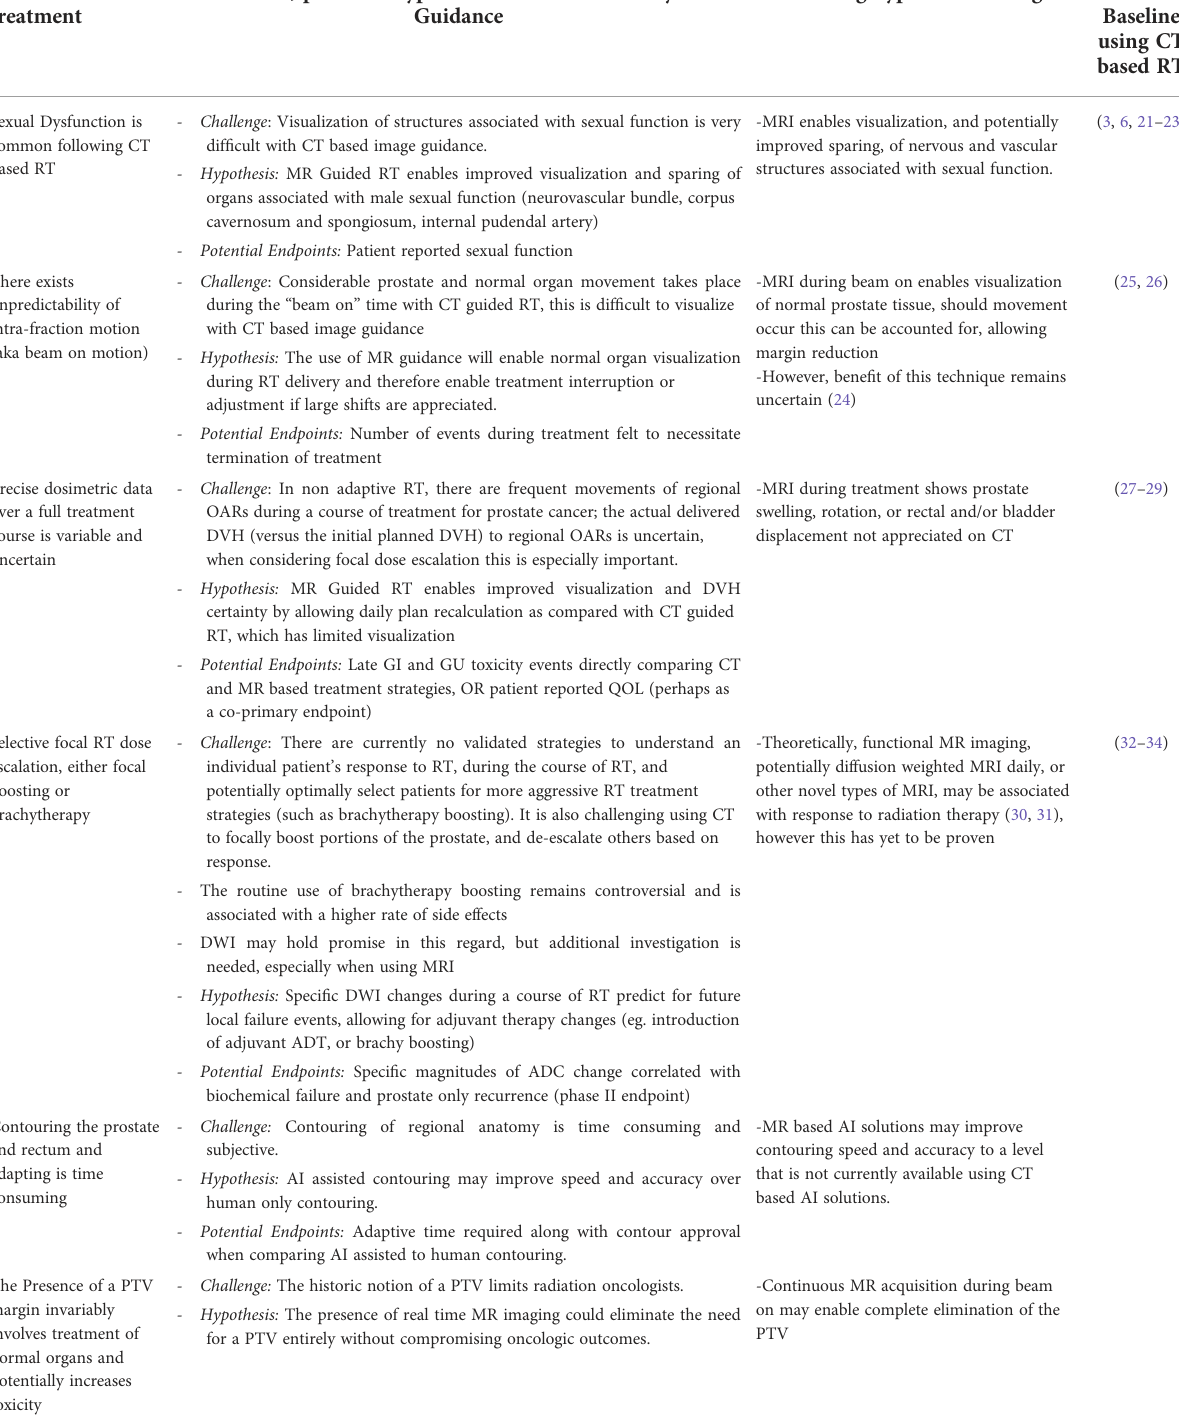
TABLE 2 a: Opportunities for Improvement in localized prostate cancer when considering adaptive MR guided RT trial designs. Challenge with CT